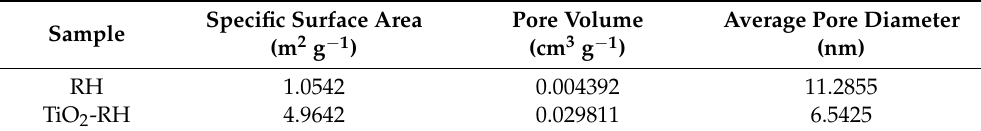
Figure 4. Adsorption-desorption profiles of ( A ) RH and ( B ) TiO 2 -RH. Table 1. Surface parameters of RH and TiO 2 -RH.